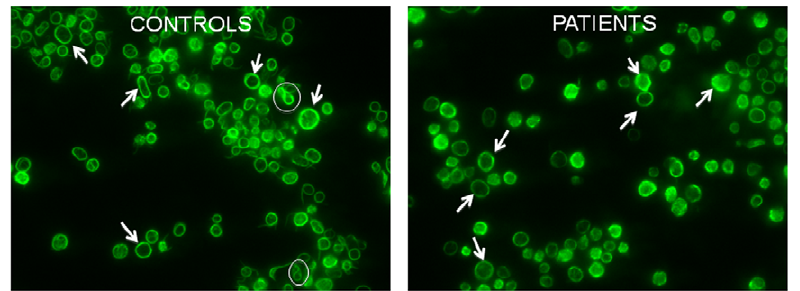
Figure 4. Conversion of preplatelets into mature platelets. In patient’s peripheral blood less ‘‘figure 8’’ shapes are present. Two ‘‘figure 8’’ shapes are circled in white in control blood (left), while no ‘‘figure 8’’ shapes are visible in this picture of patient peripheral blood (right). Arrows show examples of preplatelets.